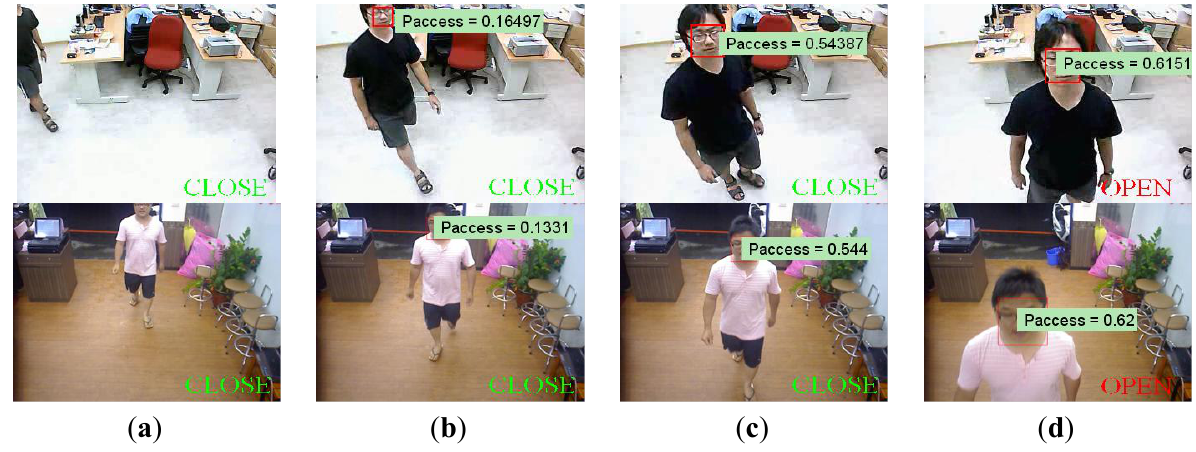
Figure 6. Opening activated by single person in lab ( first row ) and restaurant ( second row ) scenes: The cumulative probability increases if a person is continued walking toward the entrance thus the face is detected. Once the cumulative probability is greater than the threshold value, the opening action is triggered as shown in ( d ).